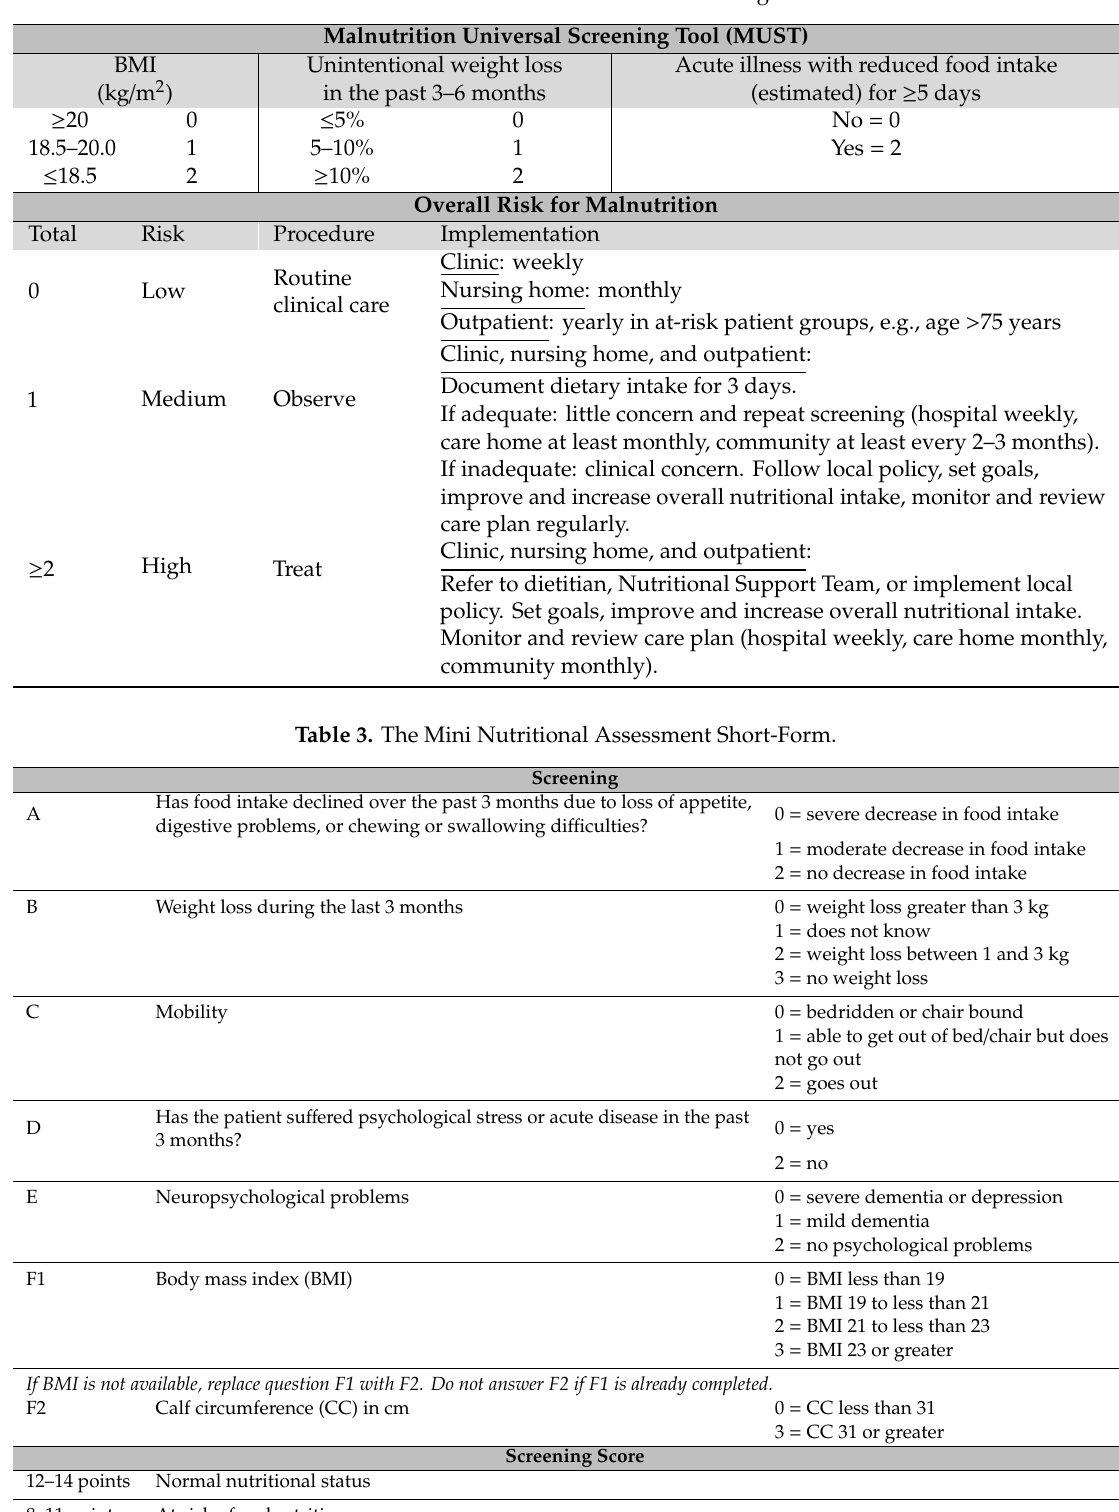
Table 2. The Malnutrition Universal Screening Tool.